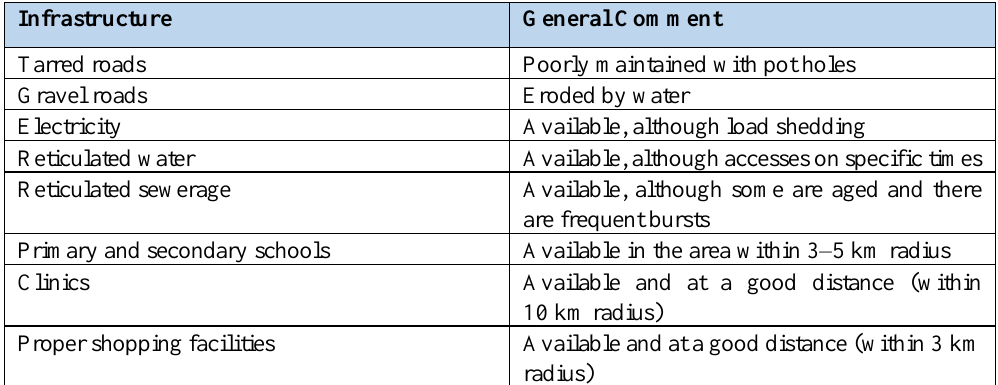
Table 1. General Conditions of Infrastructure in Most High Density Suburbs of Bulawayo (developed by the authors)